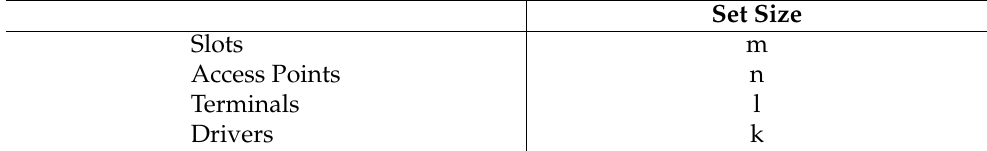
Table 7. Table of set sizes for the